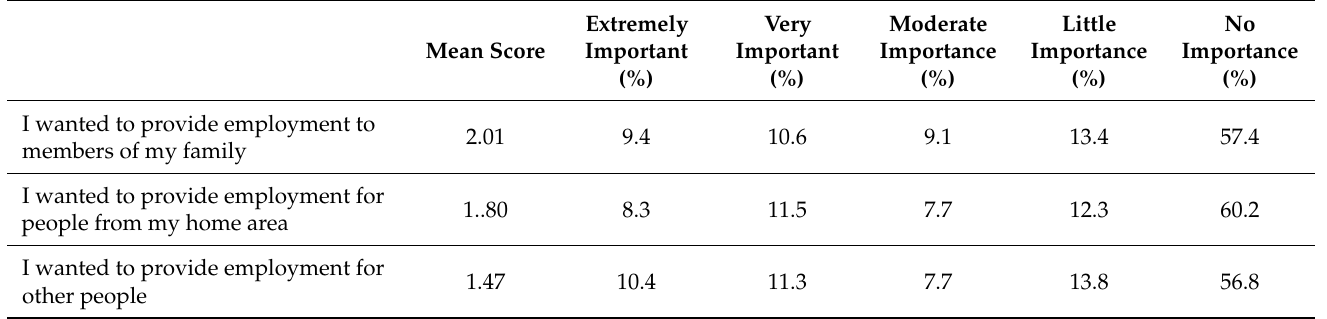
Table 10. Employment creation motivation for starting a business.